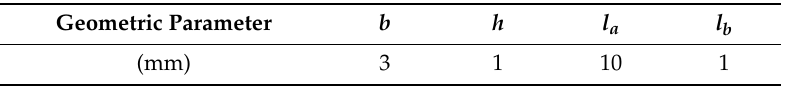
Table 2. Geometrical properties used for FEM simulation.